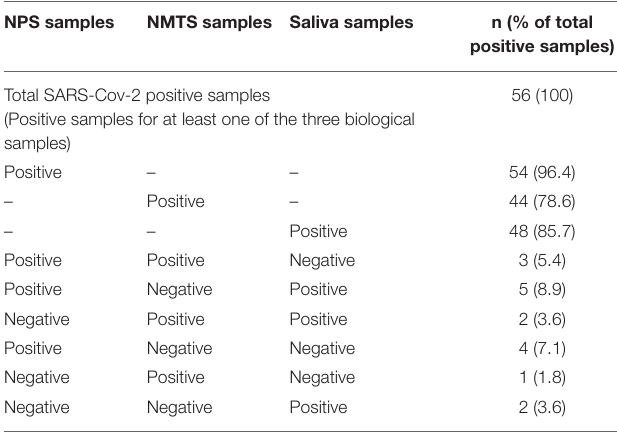
The table represents the effective of positive samples according to the RT-qPCR results obtained for the distinct sampling methods. “NPS,” nasopharyngeal swab; “NMTS,” nasal mid-turbinate swab; “Positive,” SARS-Cov-2 RT-qPCR positive assay; “Negative,” SARS-Cov-2 RT-qPCR negative assay; “–” SARS-Cov-2 RT-qPCR assay not considered.